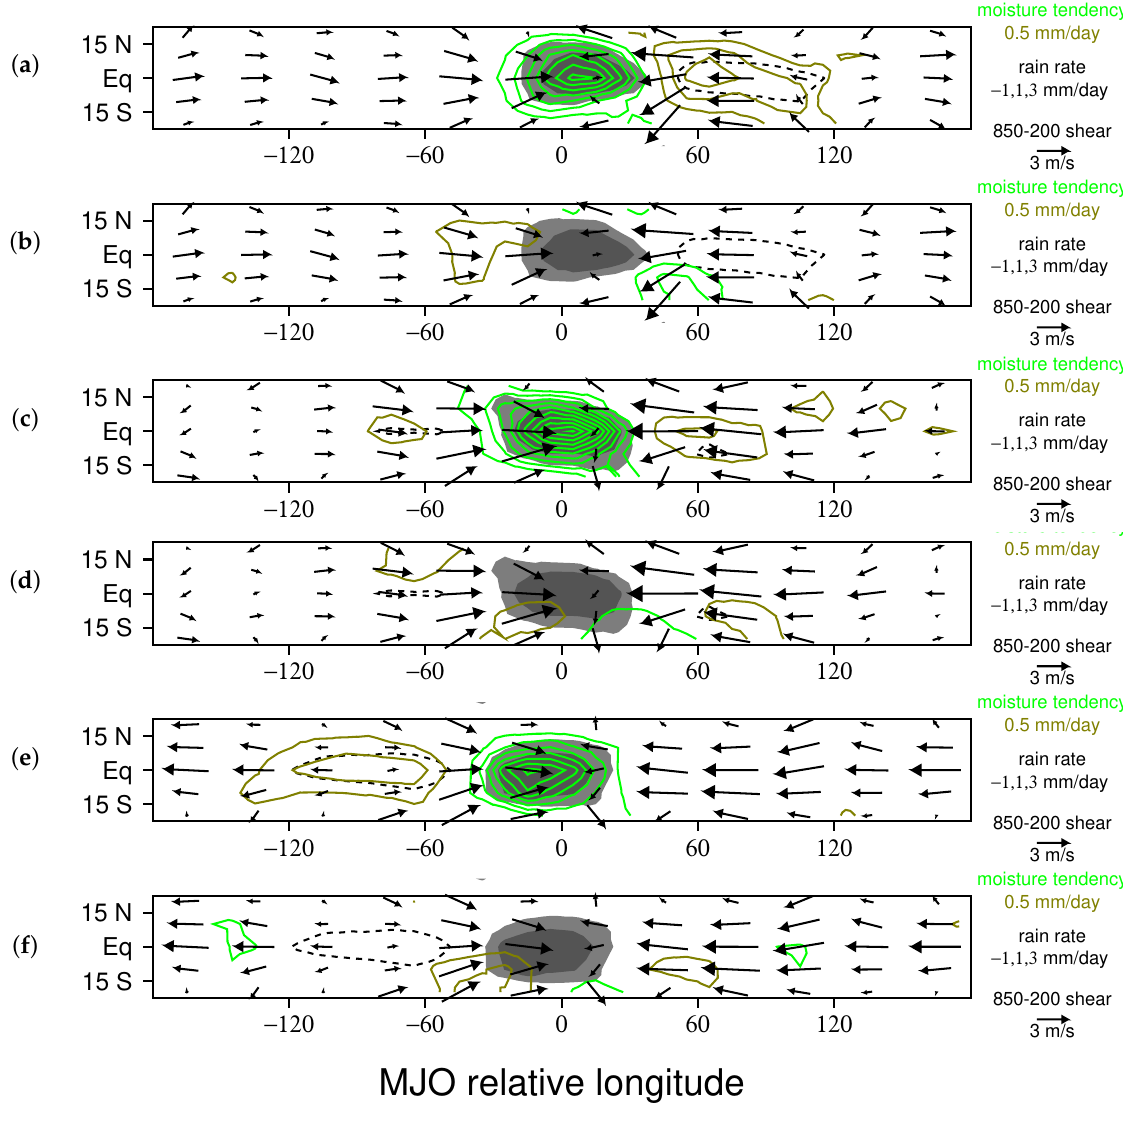
Figure 9. Moisture tendency owing to vertical ( a , c , e ) and horizontal ( b , d , f ) advection in the LAM MJO for the developing, mature, and dissipating stages, respectively. Green (brown) contours indicate moistening (drying), and vectors show the difference between 850 and 200 hPa flow. Regions with rainfall greater than 1 and 3 mm/day are shaded light and dark gray, respectively. The − 1 mm/day rainfall contour is marked with a dashed